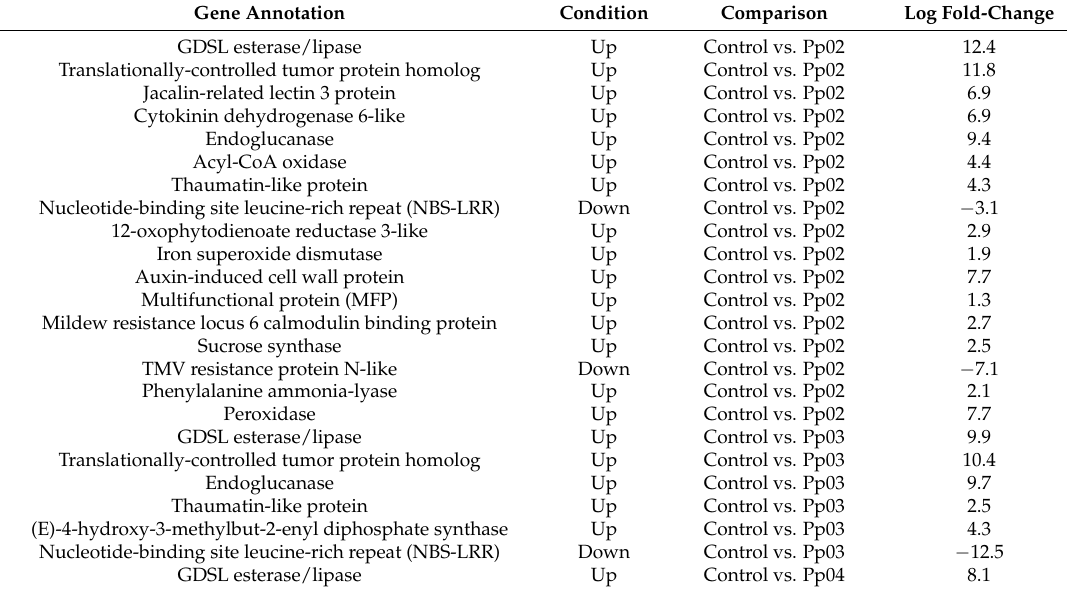
Table 3. Summary of selected DE genes (Up and Down) between different comparisons.